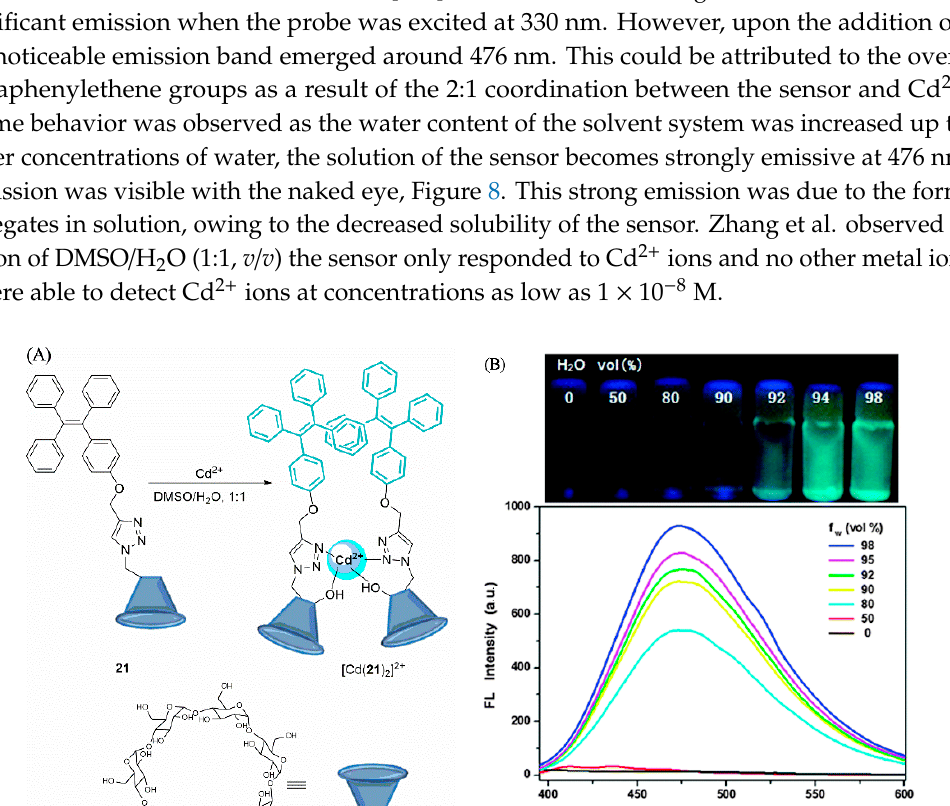
Figure 7. ( A ) Photographs of TLC plates after the immersion of molecular probe 20 into a MeOH solution ( i ) after the addition of Cd 2+ ions ( ii ) under ambient light; and ( B ) under hand-held UV-light at 365 nm, ( i ) after the addition of Cd 2+ ions, ( ii ) under hand-held UV-light at 365 nm, Adapted from [172], with permission from American Chemical Society.